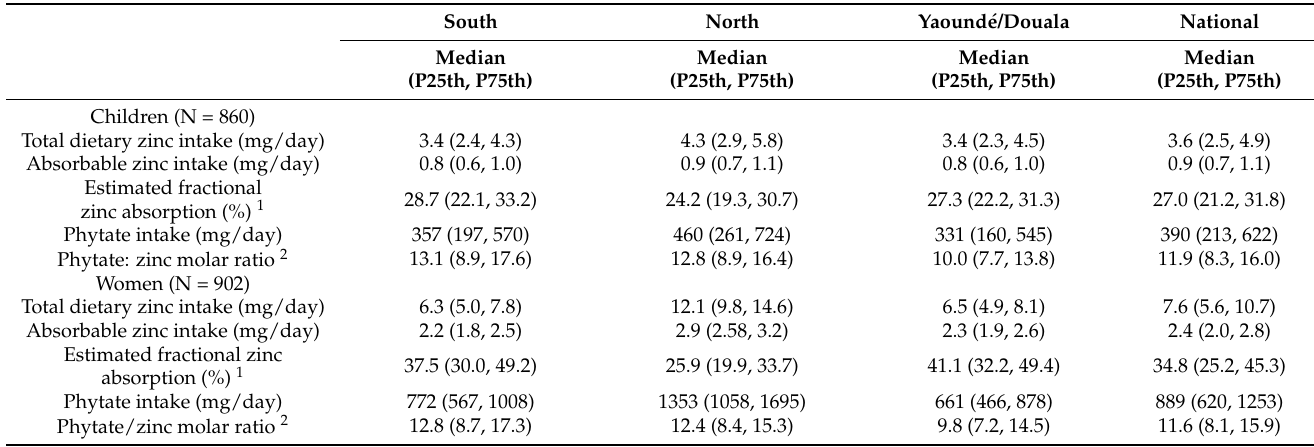
Table 2. Usual zinc and phytate intakes and phytate/zinc molar ratio among children 12–59 months of age and women of reproductive age in